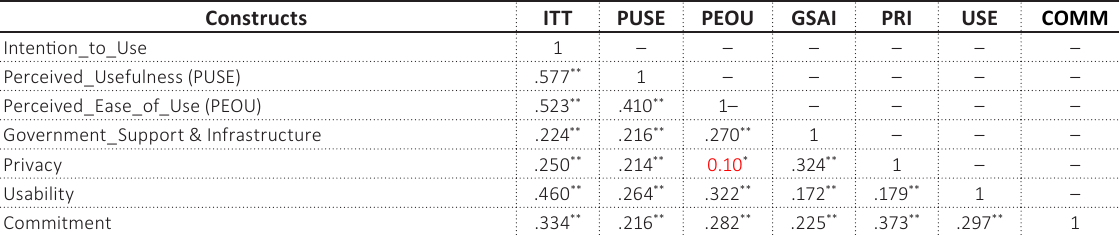
Table 4. Correlation analysis of the data collected